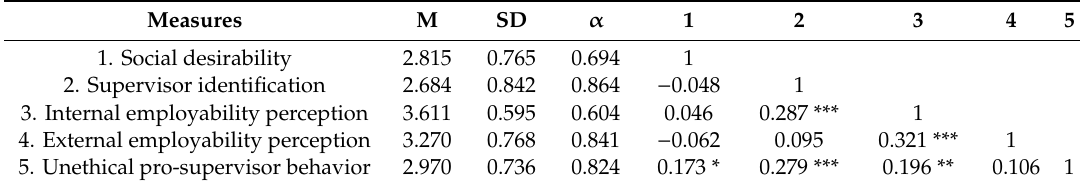
Table 2. Means, standard deviations, reliabilities, and inter-correlations.